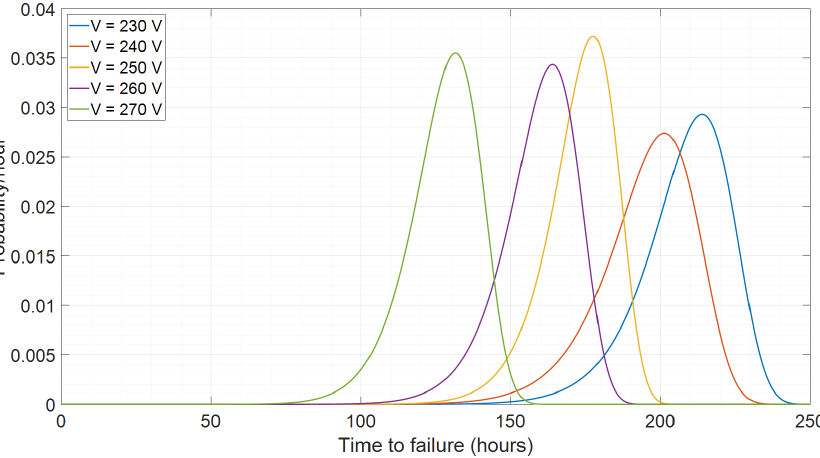
Figure 10. Probability Density Function (PDF)